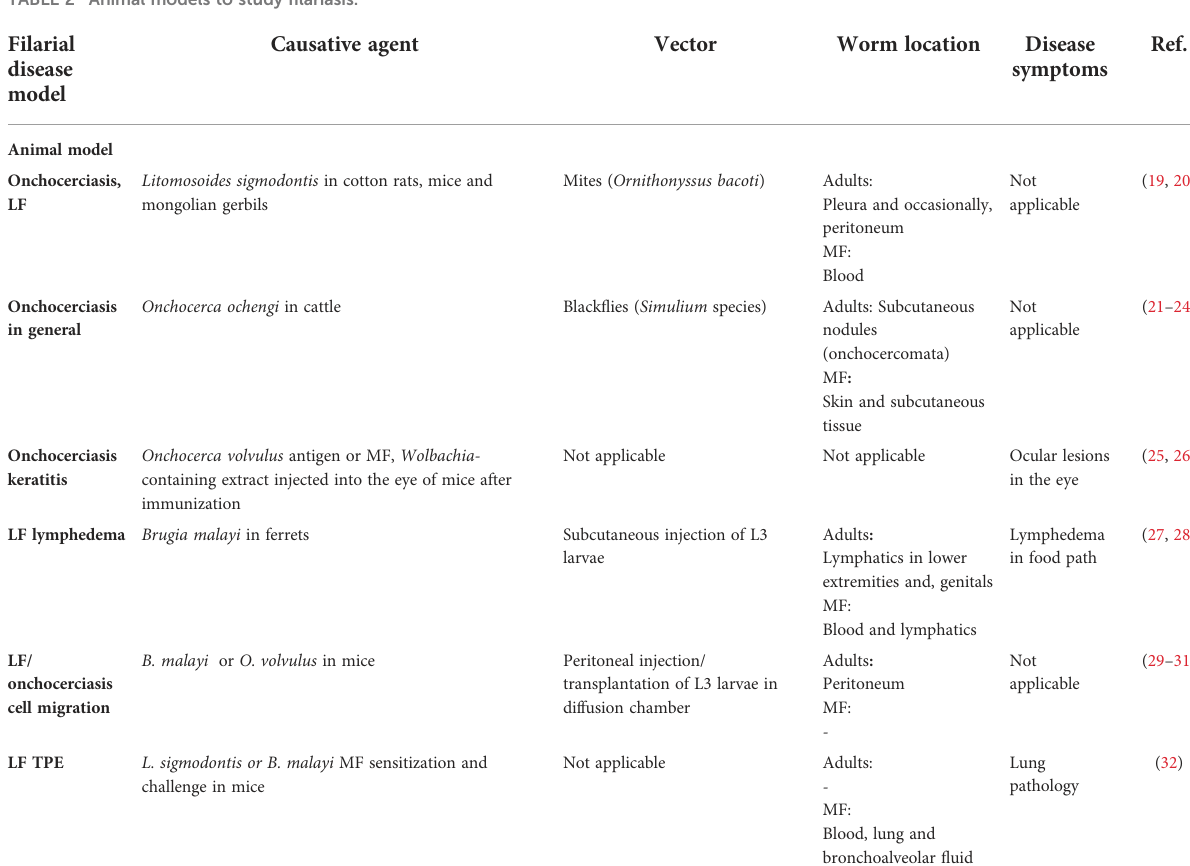
TABLE 2 Animal models to study fi lariasis. Filarial disease